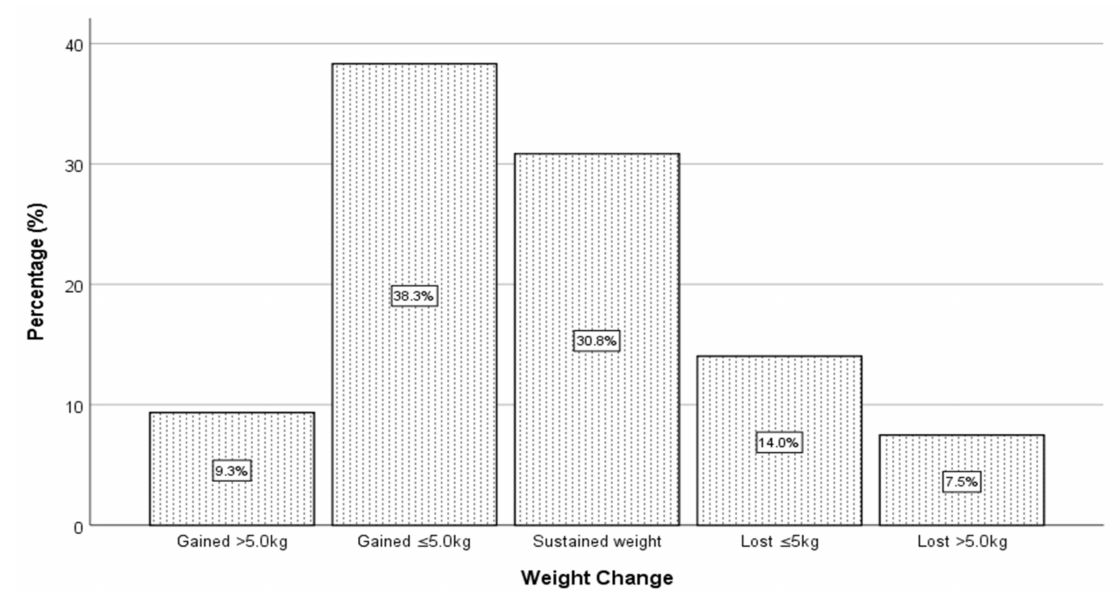
Figure 2. Weight change among Indonesian students during the COVID-19 pandemic.